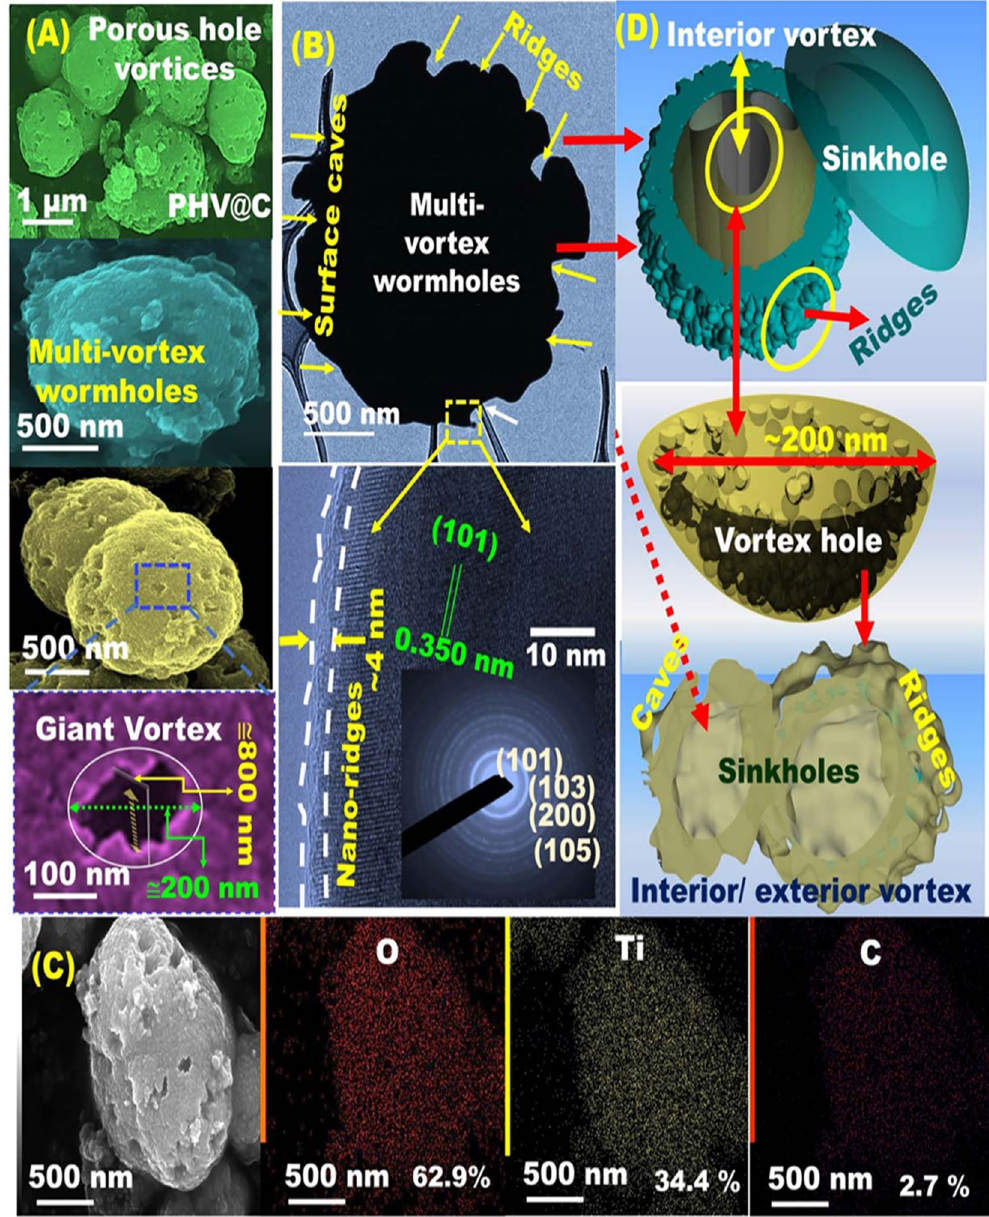
Figure 3. Representative PHV@C anodic meso-geodesics based on low- and high-magnification FESEM images ( A ), HR-TEM micrographs and electron diffraction patterns ( B ), STEM–EDS images and elemental mapping ( C ), and 3D modeling and orientation of spherical TiO2@C anatase structure with massive PHV@C. PHV@C meso-geodesics showed capture caves and ridge surfaces, vortex configurations with connective open meso/macro entrances and cage-like sinkhole core cavities, huge hollowed-out ring bowls, and cliff edges. The unique PHV@C anode module configurations formed full nests distributed and randomly oriented on spherical cuticle and well-defined and homogeneous distribution of active sites along the entire anodic electrode